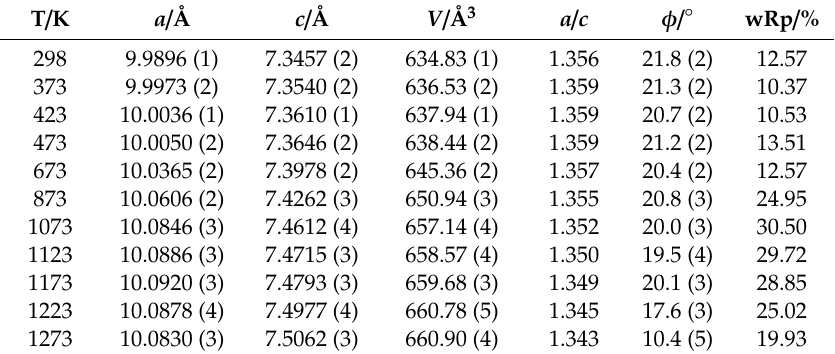
Table 1. Lattice parameters and twist angles of pyromorphite at di ff erent temperatures. T /